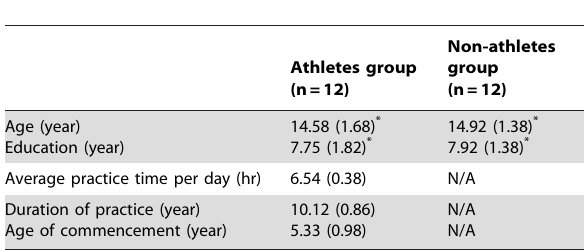
Table 1. Demographic characteristics of the